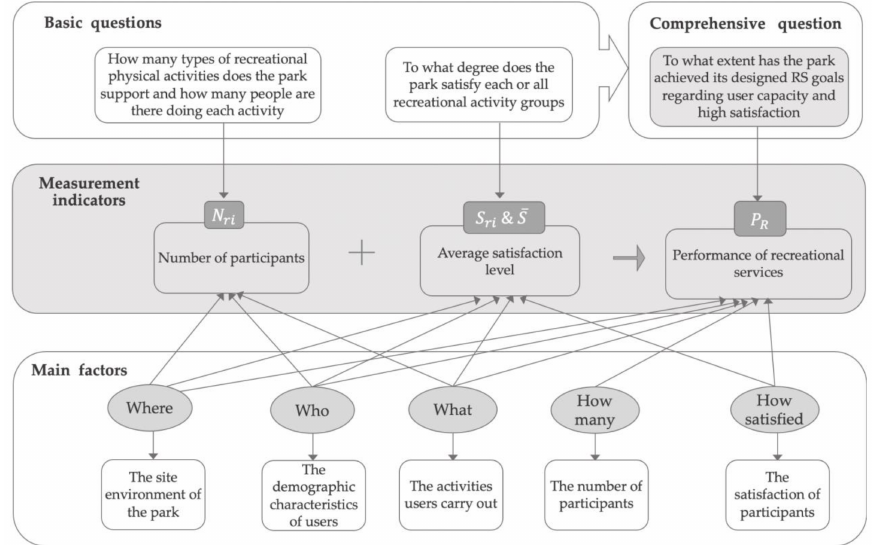
Figure 2. The conceptual framework of performance measurement indicators on recreational